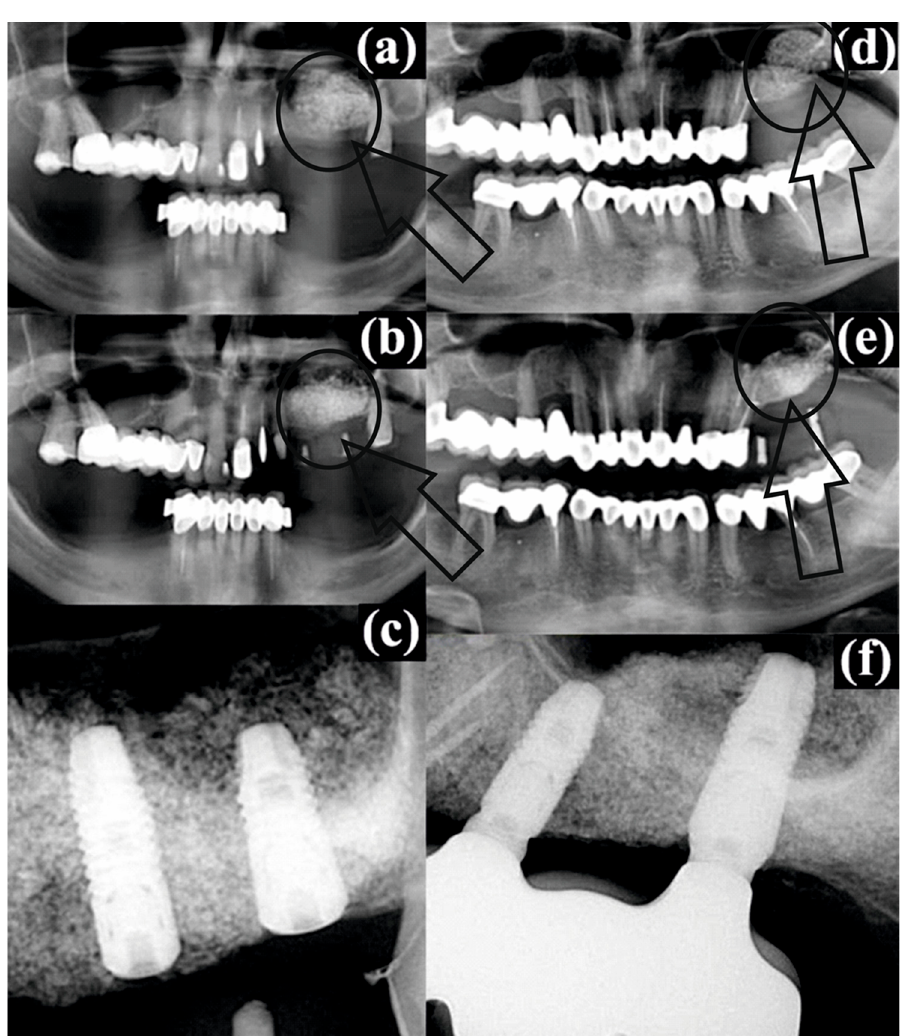
Figure 2. Radiographic images of patient #2: ( a ) the augmented bone in the left sinus immediately after sinus floor augmentation-highlighted with arrow and circle, ( b ) postoperative conditions after 4 months of healing-highlighted with arrow and circle, ( c ) dental implants in the augmented bone at 7 months after augmentation; and patient #3: ( d ) the augmented bone in the left sinus immediately after sinus floor augmentation-highlighted with arrow and circle, ( e ) postoperative conditions after 4 months of healing-highlighted with arrow and circle, ( f ) dental implants in the augmented bone at 7 months after augmentation. The augmentation loci are encircled and arrow are pointing to the regions of